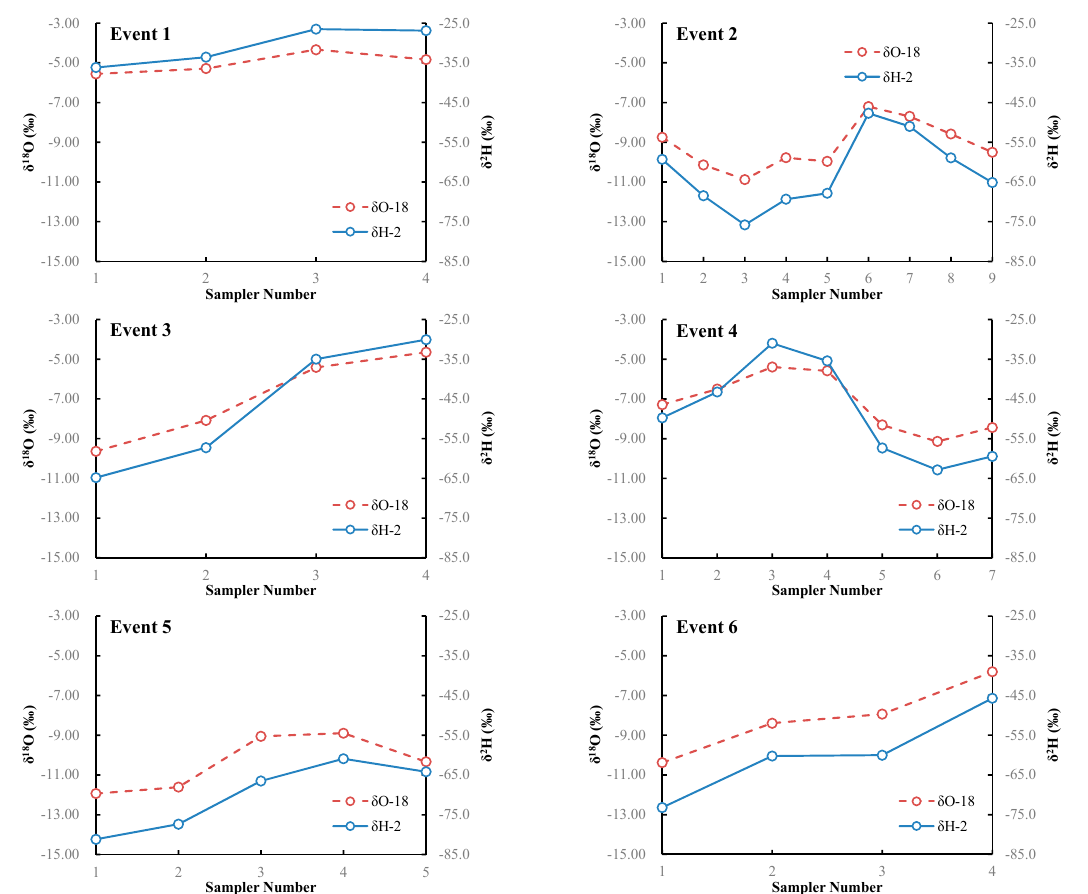
6 of 15 Table 2. δ 2 H values in precipitation for six selected rainfall events. Event Number